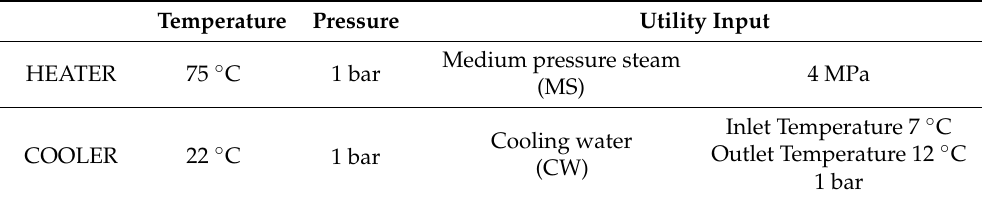
Table 4. Exchanger Characteristics.